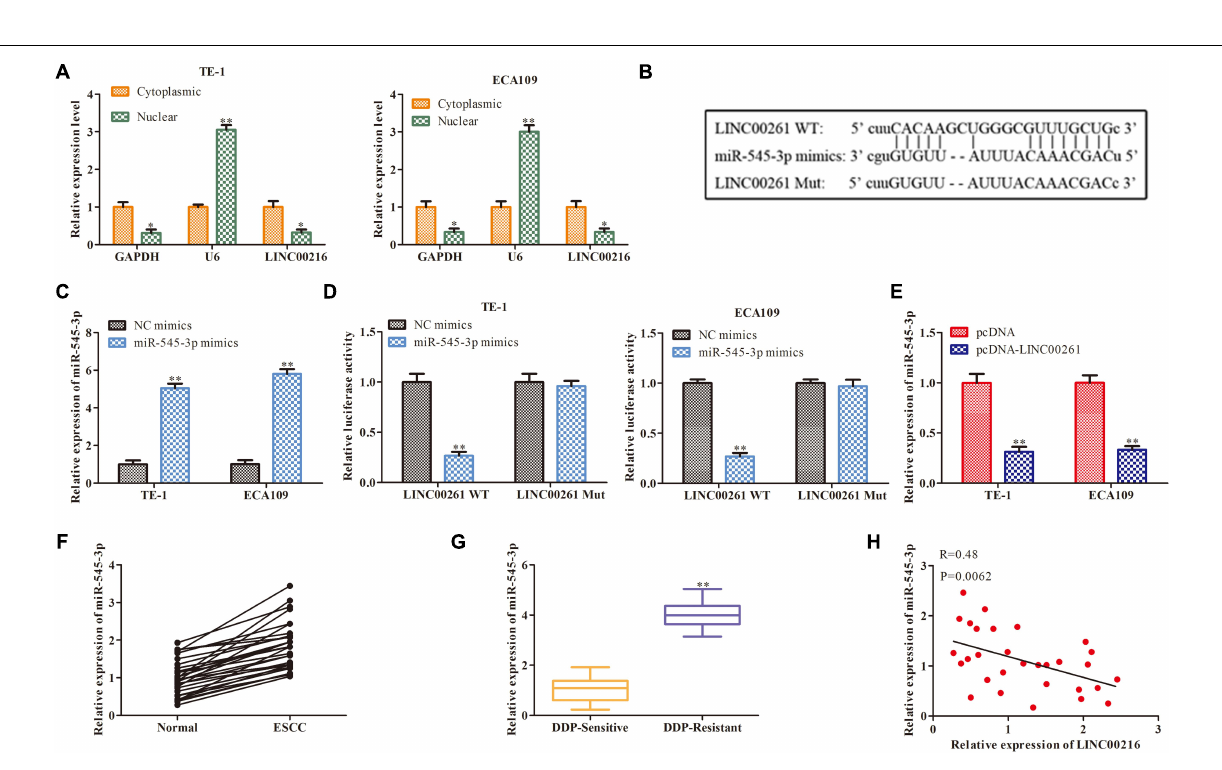
Frontiers in Cell and Developmental Biology |